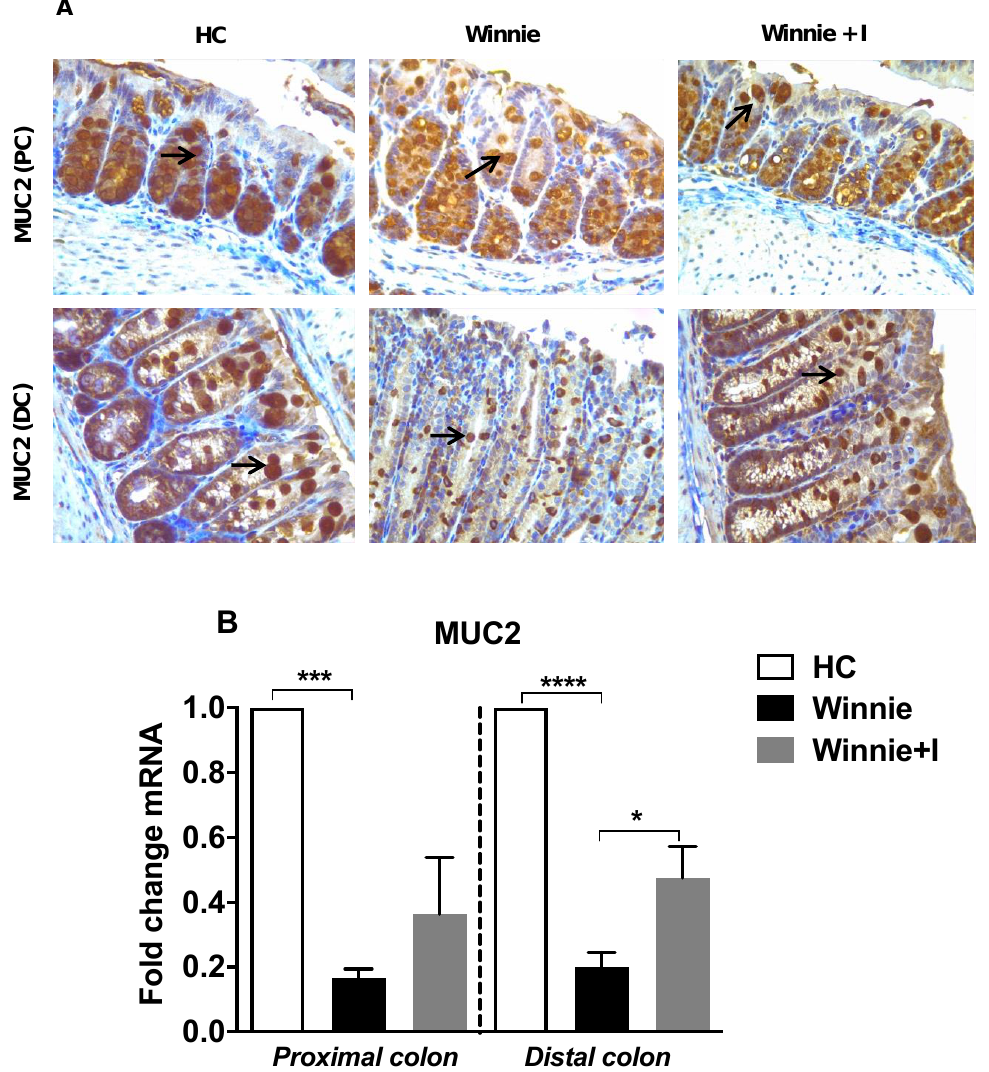
Figure 3. Effect of idebenone on mucin MUC2 expression. ( A ) Representative immunohistochemistry images of MUC2 protein expression in the proximal (PC) and distal colon (DC) ( n = 3 / group) ( B ) MUC2 mRNA expression ( n = 4 / group). MUC2 mRNA levels were normalised to GAPDH mRNA and presented as fold change. Statistical significance among groups was determined by One-way ANOVA followed by Tukey’s post-test where * p < 0.05, *** p < 0.001 and **** p < 0.0001. Images were acquired at 40× magnification. Arrows indicate localisation of staining.